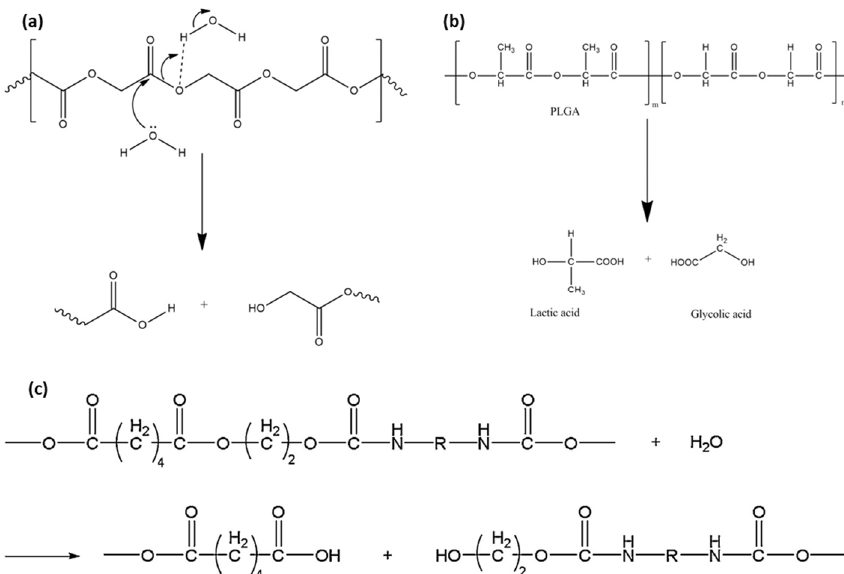
Figure 3. Degradation of ester bond based polymers. ( a ) Hydrolytic cleavage of ester bonds; ( b ) degradation of PLGA (adapted with permission [76] ©2017, Elsevier); ( c ) hydrolysis of poly(ester- urethane)s (adapted with permission [77] ©2018, Elsevier B.V.).